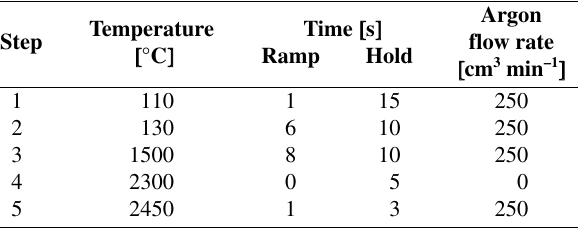
Table 1. Heating program I for the determination of total chro- mium in aqueous phase with Varian AA-20 GFAAS instrument. Temperature